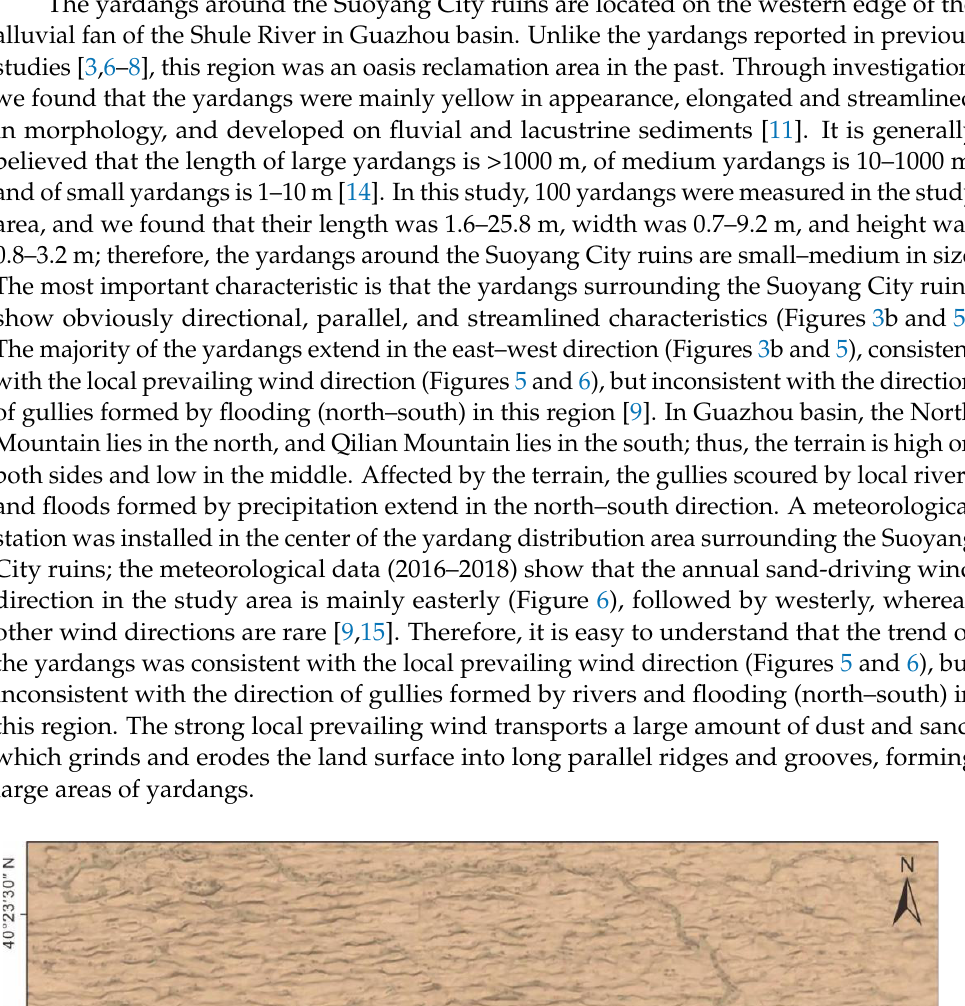
Figure 6. Annual sand-driving wind rose chart: ( A ) 2016 – 2017; ( B ) 2017 – 2018. 4.2. Controlling Factors of the Yardangs 4.2.1. Sediment Characteristics The collision and compression between the Indian and Eurasian plates since the Ce- nozoic caused rapid uplift of the Tibetan Plateau, forming a range of basin and mountain tectonic patterns. The Guazhou basin is just located in a basin mountain tectonic pattern on the northeastern edge of the Tibetan Plateau, with the Qilian Mountains to the south and the Beishan Mountains to the north. The Shule River, one of the big three inland rivers in the Hexi Corridor, runs through the basin. The Shule River sediments and the proluvial deposits brought from the Beishan and Qilian mountains formed a huge piedmont allu- vial fan. These thick Quaternary fluvial and lacustrine sediments provide material condi- tions for the development of agriculture and the formation of yardangs. 4.2.2. Fluvial Erosion Yardangs are considered to be among the most typical wind-eroded landforms, but the role of water flow should not be ignored. Despite an extreme arid climate, the inter- mittent water flow formed by precipitation plays an important role in the development of yardangs. Although the average annual precipitation in Guazhou is only 64.96 mm (Fig- ure 2), the precipitation during rainstorms is sufficient to form surface runoff and erode